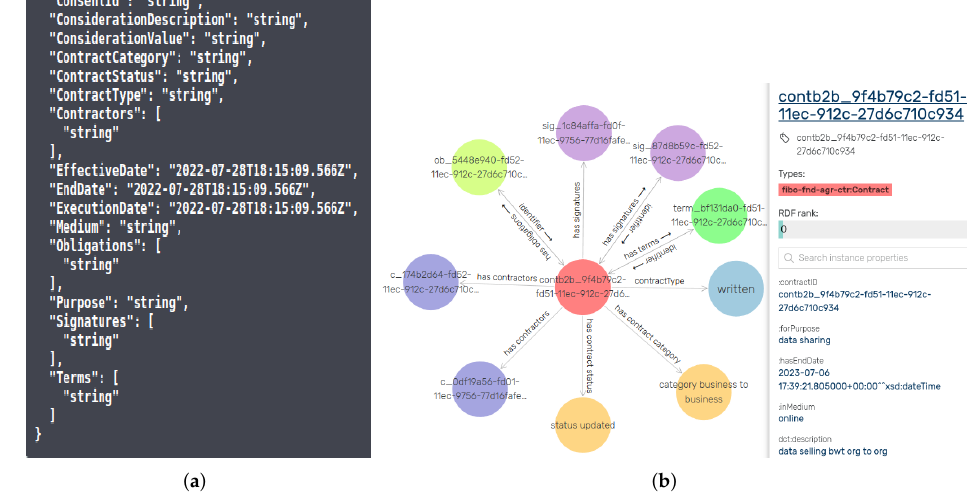
Figure 6. A snapshot of the JSON schema used for contract and the contract module’s creation (or representation) of contract in the legal KG. ( a ) Contract JSON schema. ( b ) KG representation of a contract in